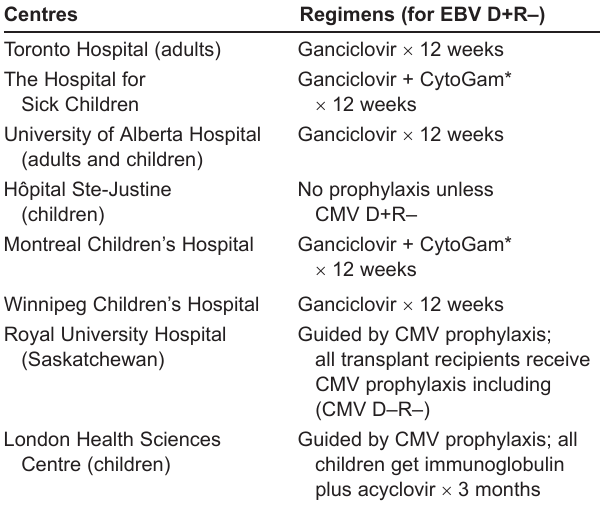
TABLE 3 Regimens used for prophylaxis against